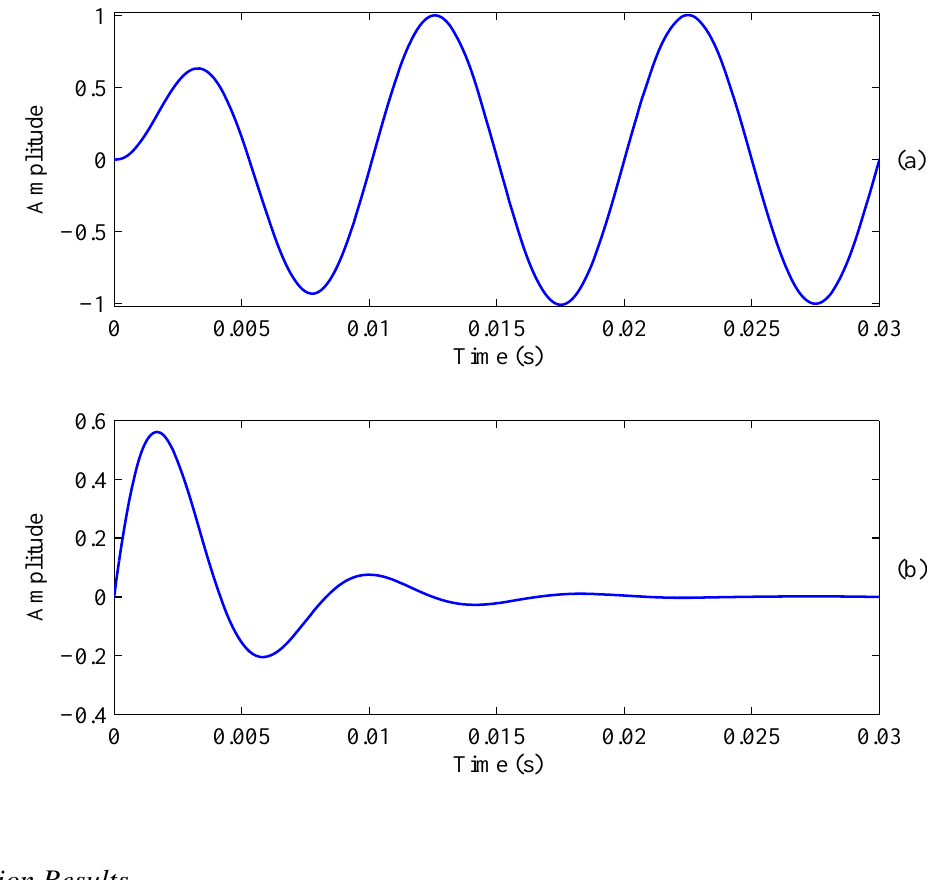
Figure 11. Time response of the closed-loop system for: ( a ) the sinusoidal reference of frequency 2 ω ; and ( b ) the sinusoidal disturbance of frequency 2 ω 1